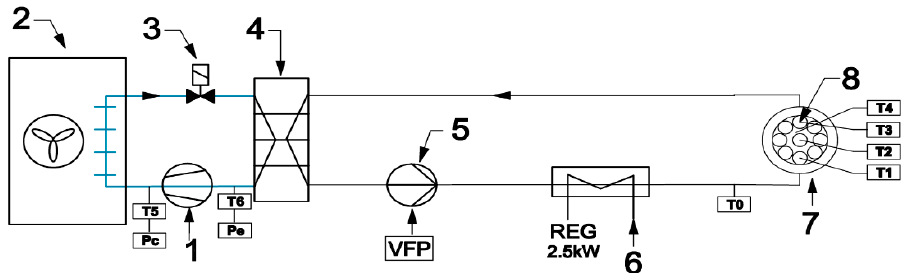
Figure 2. Layout of experimental setup: ( 1 ) compressor; ( 2 ) condenser; ( 3 ) electronic expansion valve; ( 4 ) evaporator; ( 5 ) circulating pump; ( 6 ) heater; ( 7 ) water bath; and ( 8 ) samples. Four K-type thermocouple sensors with 1 mm shield diameter were installed in the center of four samples containing different PCMs. Sensor T0, located upstream of the water bath, was used to control the electric heater. All thermocouples were calibrated and tested before installation using the Beamex MC6 calibrator (BEAMEX OY AB, Pietarsaari, Finland), the DRUCK DB-150 (GE-Sensing, Billerica, MA, USA) calibration furnace, and the reference temperature sensor PT100 ISOTECH (Isothermal Technology Ltd., Southport, England). After that, the precision of the thermocouples was ± 0.1 ◦ C for 0 ◦ C and ± 0.15 ◦ C for 30 ◦ C. The value of the standard deviation of the temperature measurement was 0.15 K. Pressure transducers (marked as Pe and Pc in Figure 2) were used by the refrigerant cycle safety and control system. A view of the experimental setup is shown in Figure